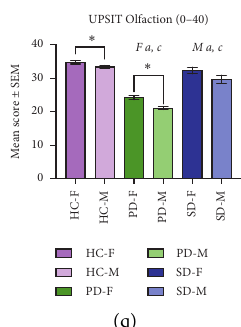
Figure 1: Prevalence of NMS at onset, categorized by sex. NMS mean scores were categorized by sex of participant (female (F) or male (M)) for Parkinson’s disease (PD), SWEDD (SD), and healthy controls (HC). NMS scales analyzed are displayed A through Q indicating the score range in the title. Higher number indicates more dysfunction except for MoCA Cognition (J) and USPIT Olfaction (O). Pairwise differences within the cohort (females vs. males) were evaluated with independent-samples Mann–Whitney U test with Bonferroni correction for multiple comparisons. Differences between cohorts (HC vs. PD vs. SWEDD) for each sex were evaluated using the independent-samples Kruskal–Wallis test. Statistical differences within cohorts (females (v) males) are indicated by an asterisk ∗ . Post hoc analyses signifying differences between the HC, PD, and SWEDD cohorts are indicated for females (F) and males (M) as a � HC versus PD, b � HC versus SWEDD, and c � PD versus SWEDD. p < 0 .